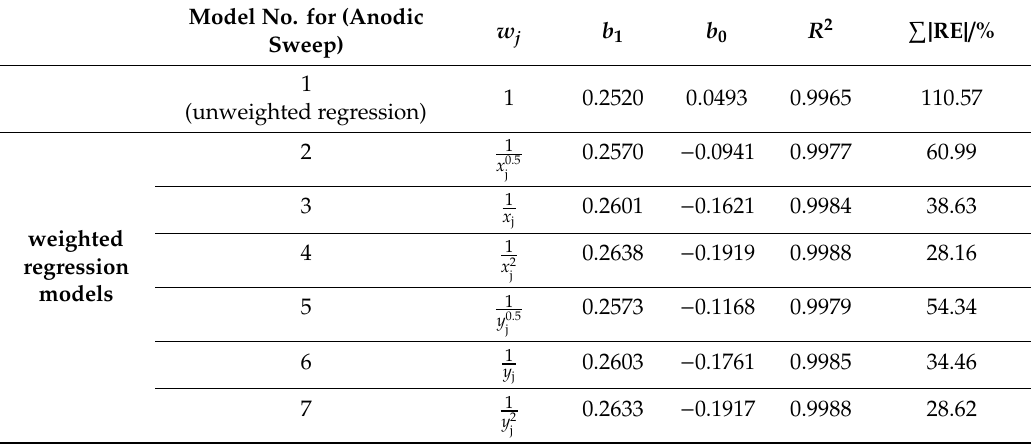
(cid:80) | RE | ) obtained for